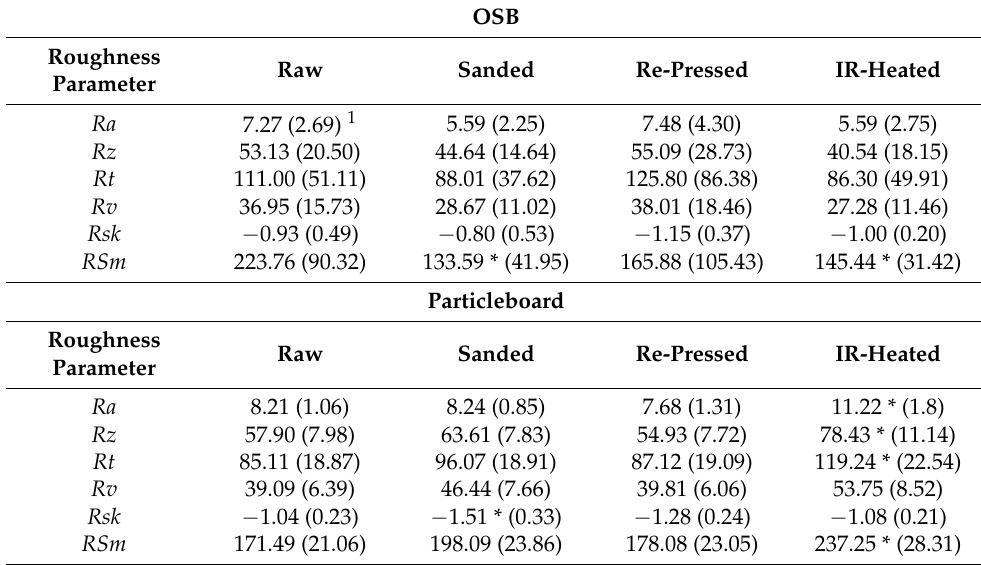
Table 4. Results of roughness measurements on OSB and particleboard.